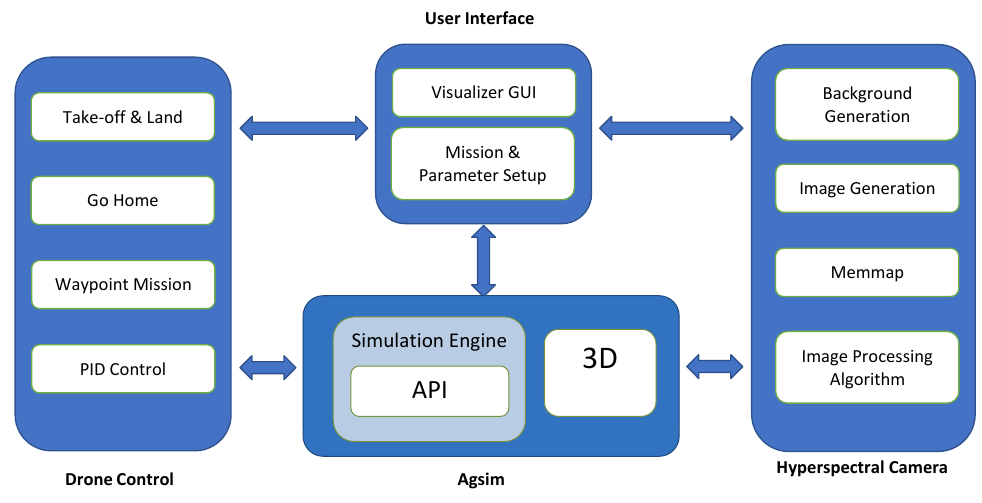
Figure 4. Hyperspectral simulation environment block